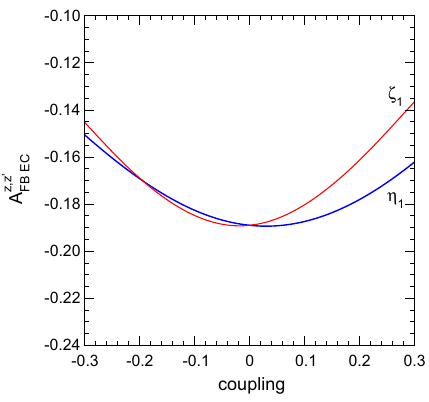
(cid:3) ontheparameters η 1 and FB,EC